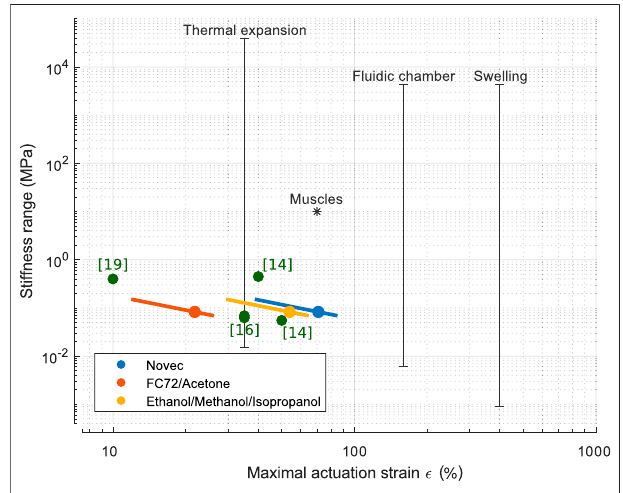
FIGURE10| Comparisonoftheexperimentalresultswiththeliteraturein a stiffness – strain diagram. Previously reported PCMEC actuators are represented in green. The black lines represent other relevant classes of transducers and indicate the maximal strain and the extreme stiffness values reported in the literature (Decroly et al., 2020). The data points are completed by lines ∼ 1 / ϵ covering the investigated stiffness